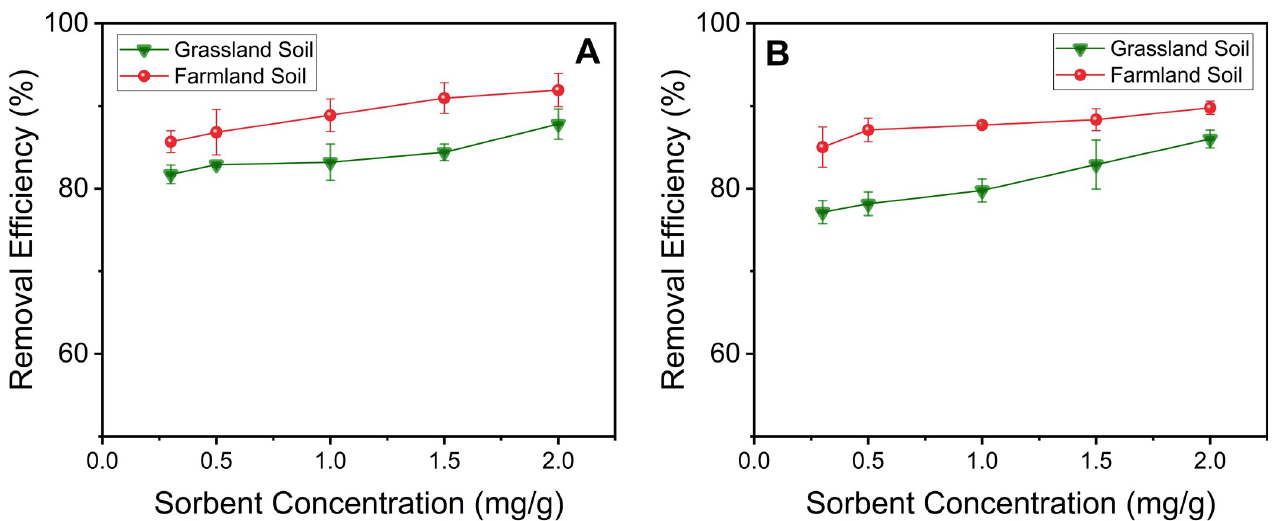
Fig 4. Removal efficiencies of (A) Pb 2+ and (B) Cd 2+ by Ligand DNPs at pH 7 in the presence of additional (1%) soluble NOM.